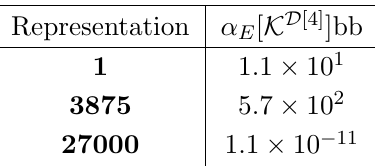
Table 3 . The extremal functional optimizing the lower bound on C J for interacting theories with E 8 (cid:13)avor group, at derivative order (cid:3) = 48, acted on the contributions of the D [4] multiplets to the crossing equation in each channel.